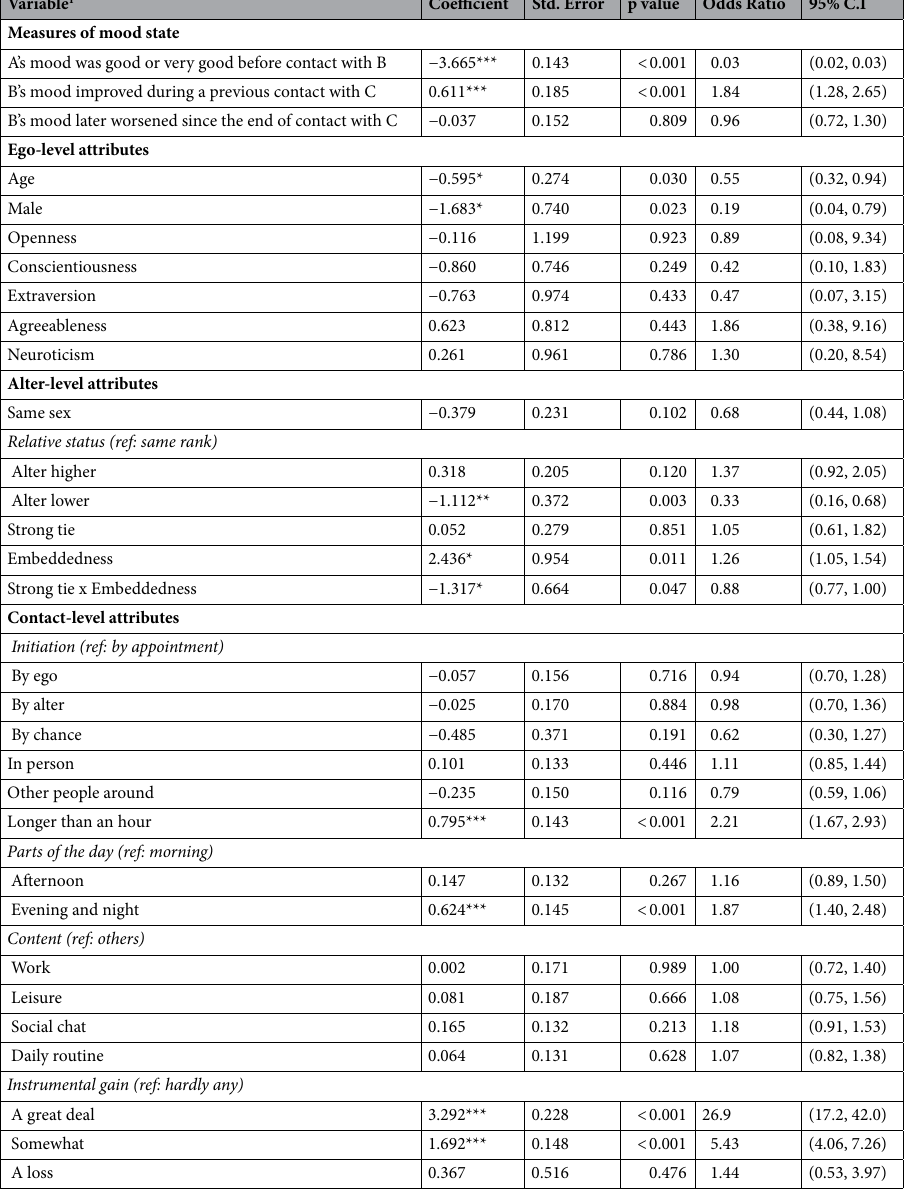
Table 2. Pooled estimates of the coefficients with standard errors and corresponding odds ratios with 95% confidence intervals in the mixed logistic regression model of positive mood change from 100 imputed datasets. 1 All variables are binary except age, for which the odds ratio is calculated based on the increase of ten years, and embeddedness, for which the odds ratio is calculated based on the increase of one-tenth of the embeddedness score. *: p-value < 0.05; **: p-value < 0.01; ***: p-value <